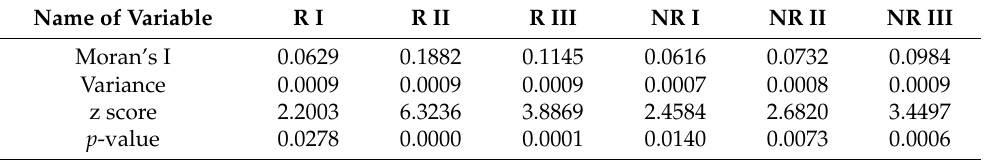
Table 2. The Moran’s I index of the transmission locations of COVID-19 in different